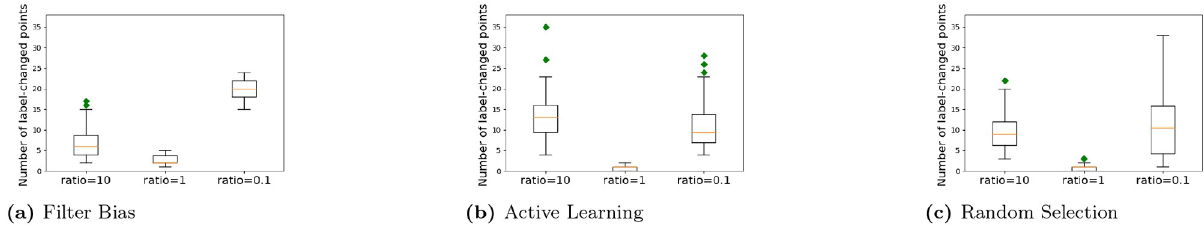
Fig 9. The box-plots showing the distribution of the number of points that moved across the boundary in the first and last iterations of the iterated learning for three iterated algorithmic biases with different class imbalanced initialization ratios. Because the number of points that move across the boundary indicates the intensity of the boundary shift, this shows that for all three iterated algorithmic bias modes, a high imbalanced initialization results in a higher boundary shift compared to a balanced initialization.